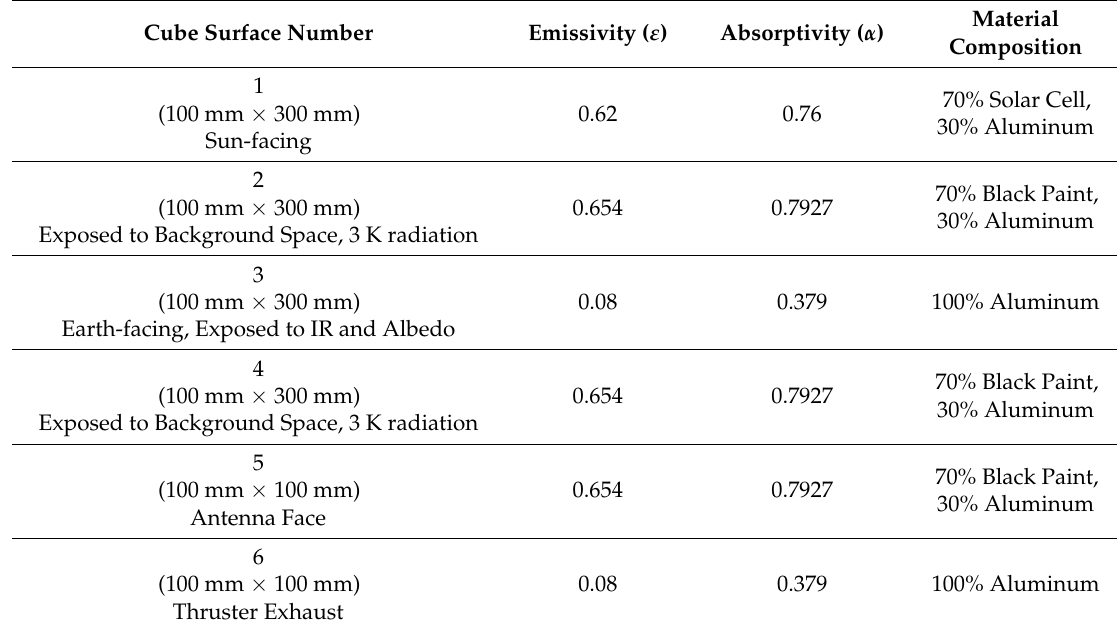
Table 29. Material Selection for the CubeSat